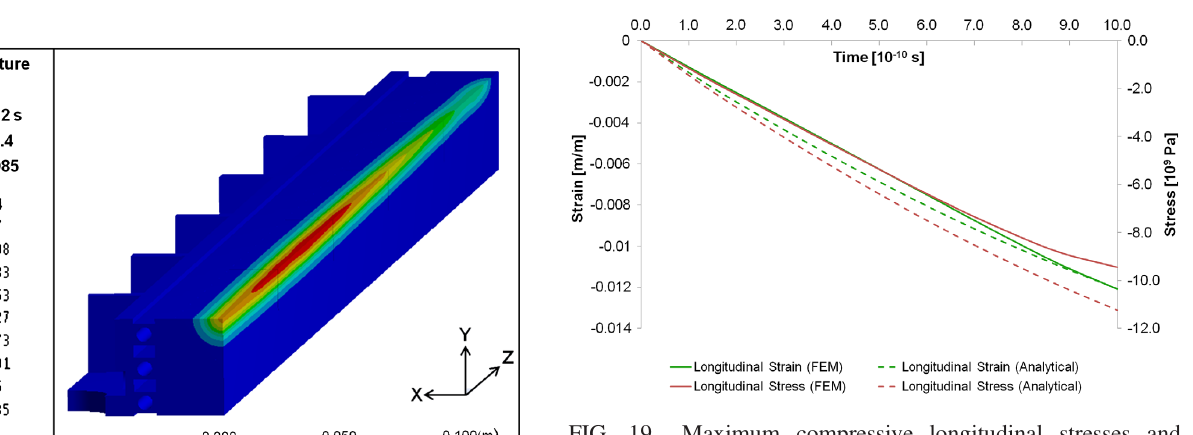
FIG. 19. Maximum compressive longitudinal stresses and strains that develop within the jaw inserts over the duration of the beam impact (1 ns). Values obtained as a result of FEM simulations as well as analytically, using Eqs. (8) and (9), are